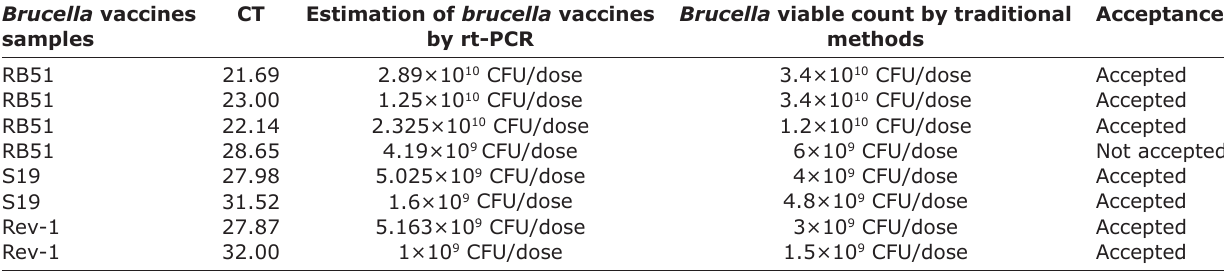
Table-4: Brucella count by traditional methods and RT-qPCR based on a standard graph generated by brucella RB51 DNA within the range. Brucella vaccines CT Estimation of brucella vaccines Brucella viable count by traditional samples by rt-PCR